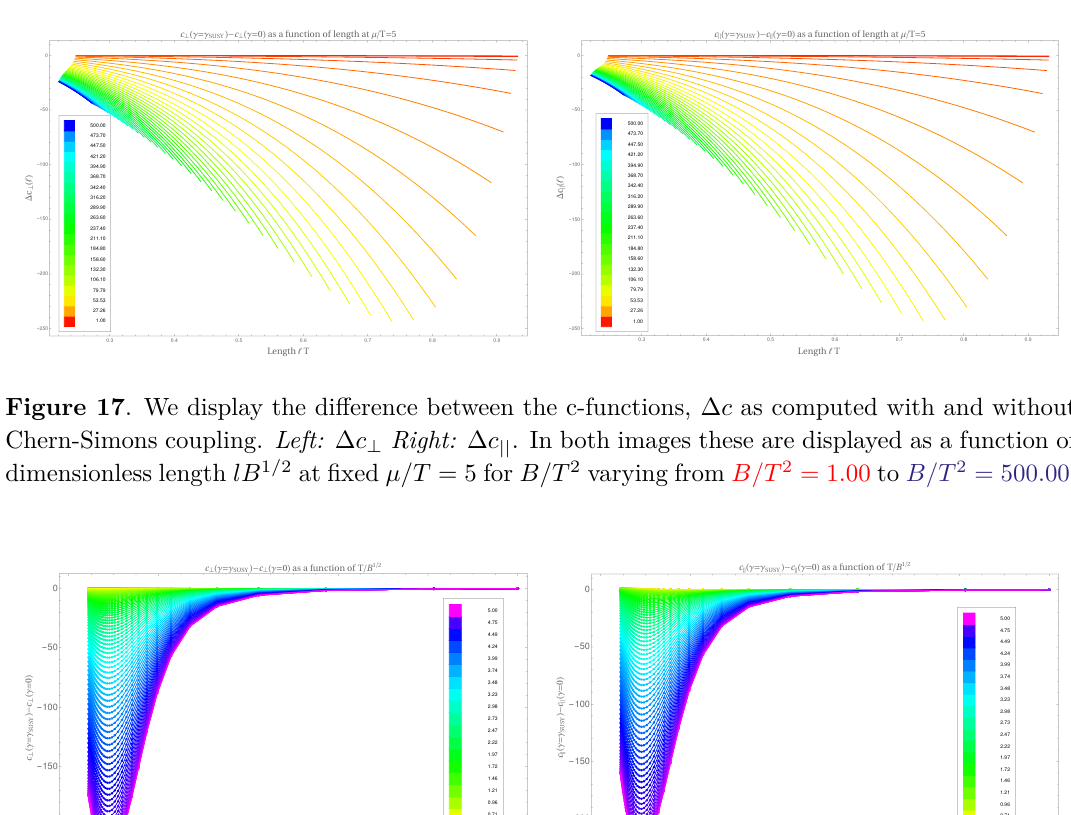
. In both images these ||